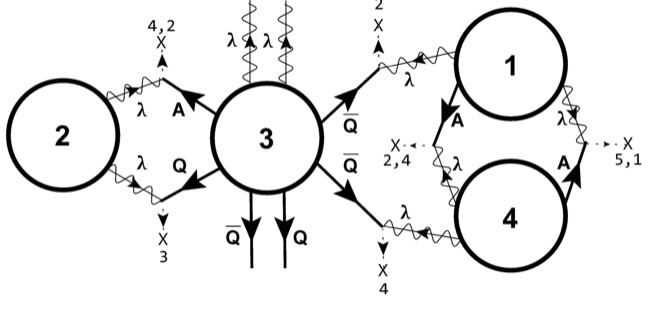
Figure 6: A sketch of the multi-monopole composite formed for F = 2 when the gauge group breaks from SU ( 5 ) to SU ( 2 ) ; the antisymmetric and squark VEVs, (61) and a (62), are represented as a cross with their color